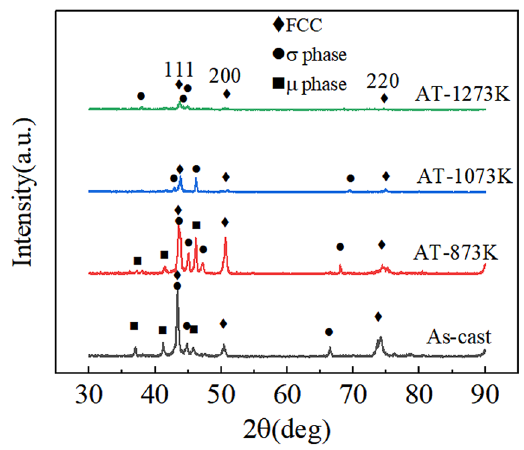
Figure 1: XRD patterns of as - cast and annealed FeCoCrNiMo